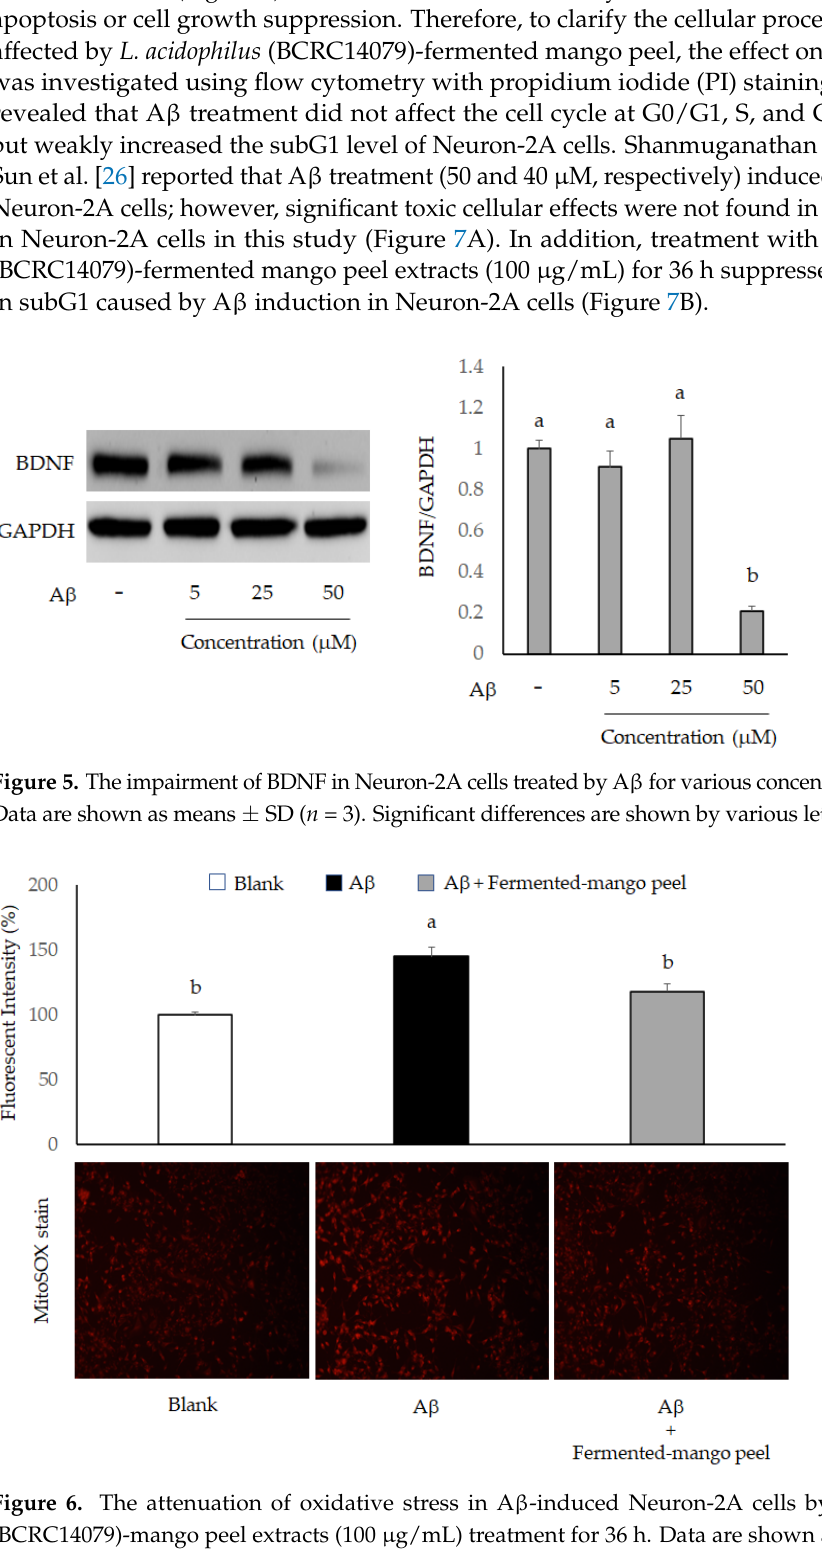
Figure 7. The levels of cell cycle and subG1 in Neuron-2A cells treated by A β with or without L. acidophilus (BCRC14079)-fermented mango peel extracts for 36 h. ( A ) Cell cycle distribution. ( B ) Quantitative results of cell cycle percentage distribution. Data are shown as means ± SD ( n = 3). Significant differences are shown by various letters ( p < 0.05).